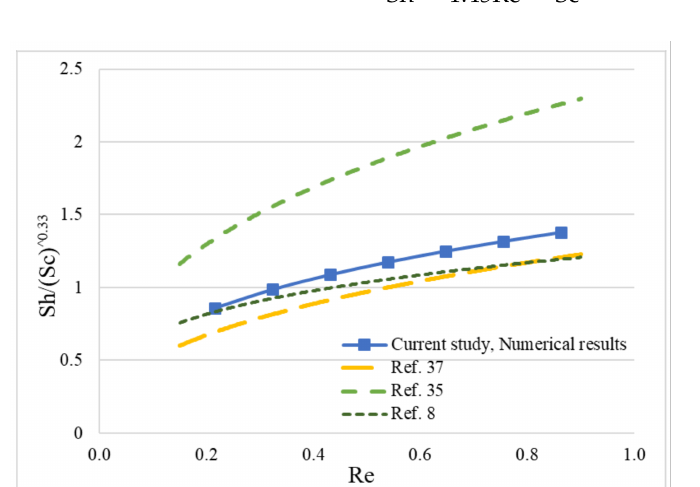
Figure 7. Correlation among Re, Sc and Sh numbers, based on both of the modeling results and experimental results of this study and the results of previous